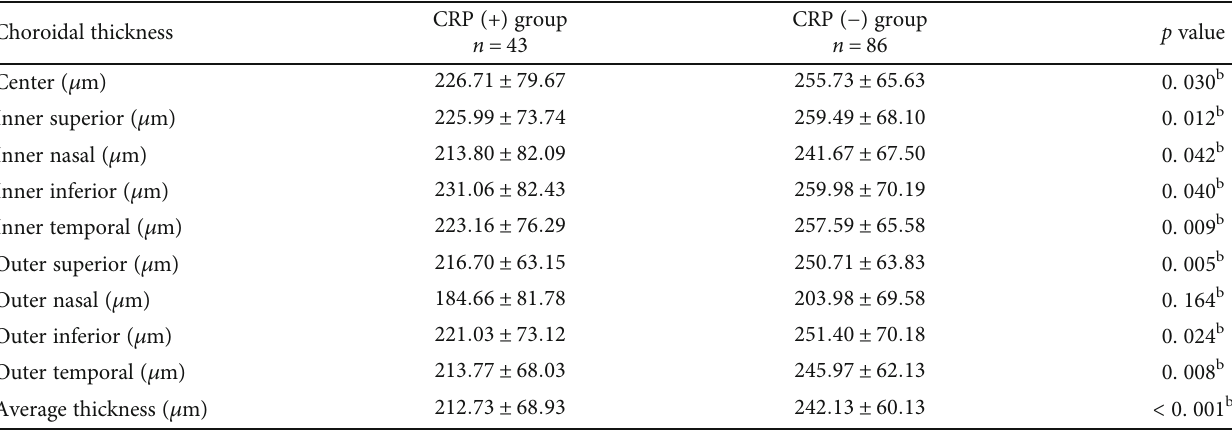
Table 3: The choroidal thickness of nine sectors of the ETDRS grid.